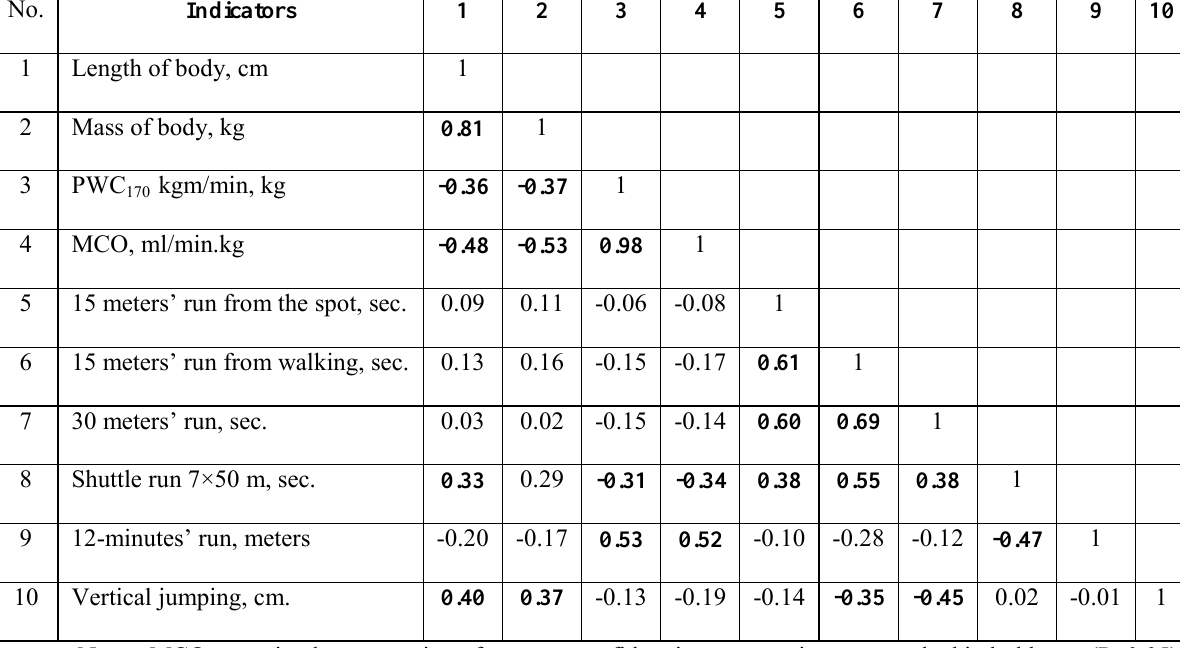
Correlation matrix of interconnections of indicators of junior football players’ (16-17 years old age) physical fitness